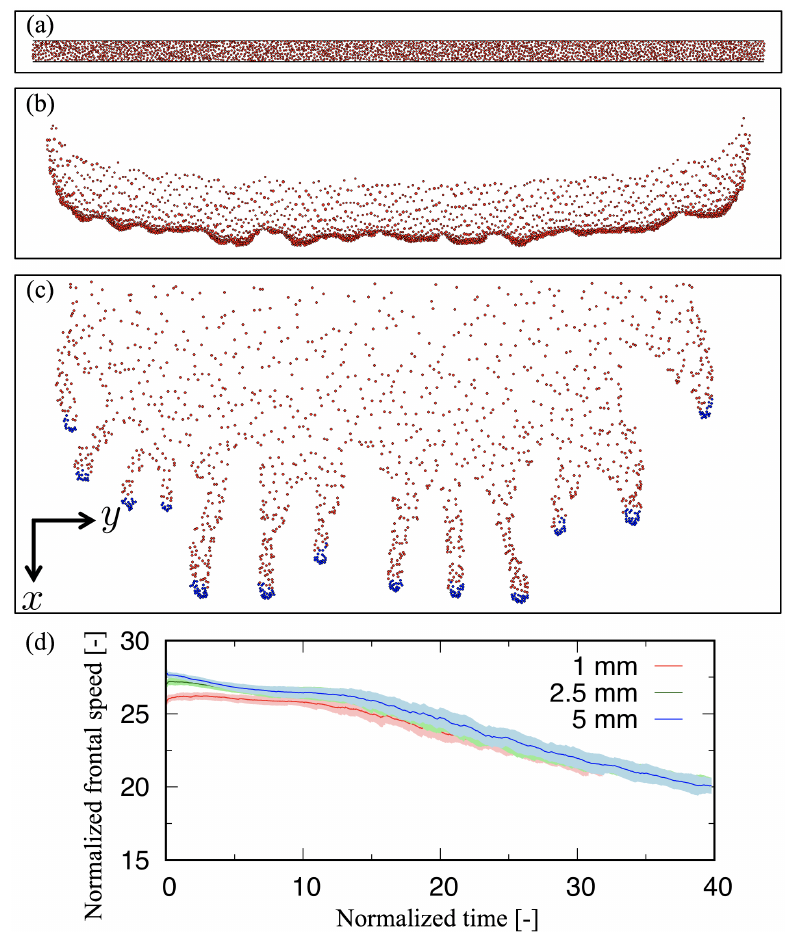
Figure 6. Flow instability from the straight shape to the wavy pattern with a p = 5 mm in the rectangular set-up: ( a ) ˜ t = 0, ( b ) ˜ t = 7.96, and ( c ) ˜ t = 39.8. ( c ) The blue particle belongs to the aggregated part detected as the head, according to Equation (11b). ( d ) Three normalized frontal speeds ˜ v f ( ˜ t ) are shown at a p = 1, 2.5, and 5 mm. The mean and standard deviation of 20 simulations are denoted by the solid curve and thin band,